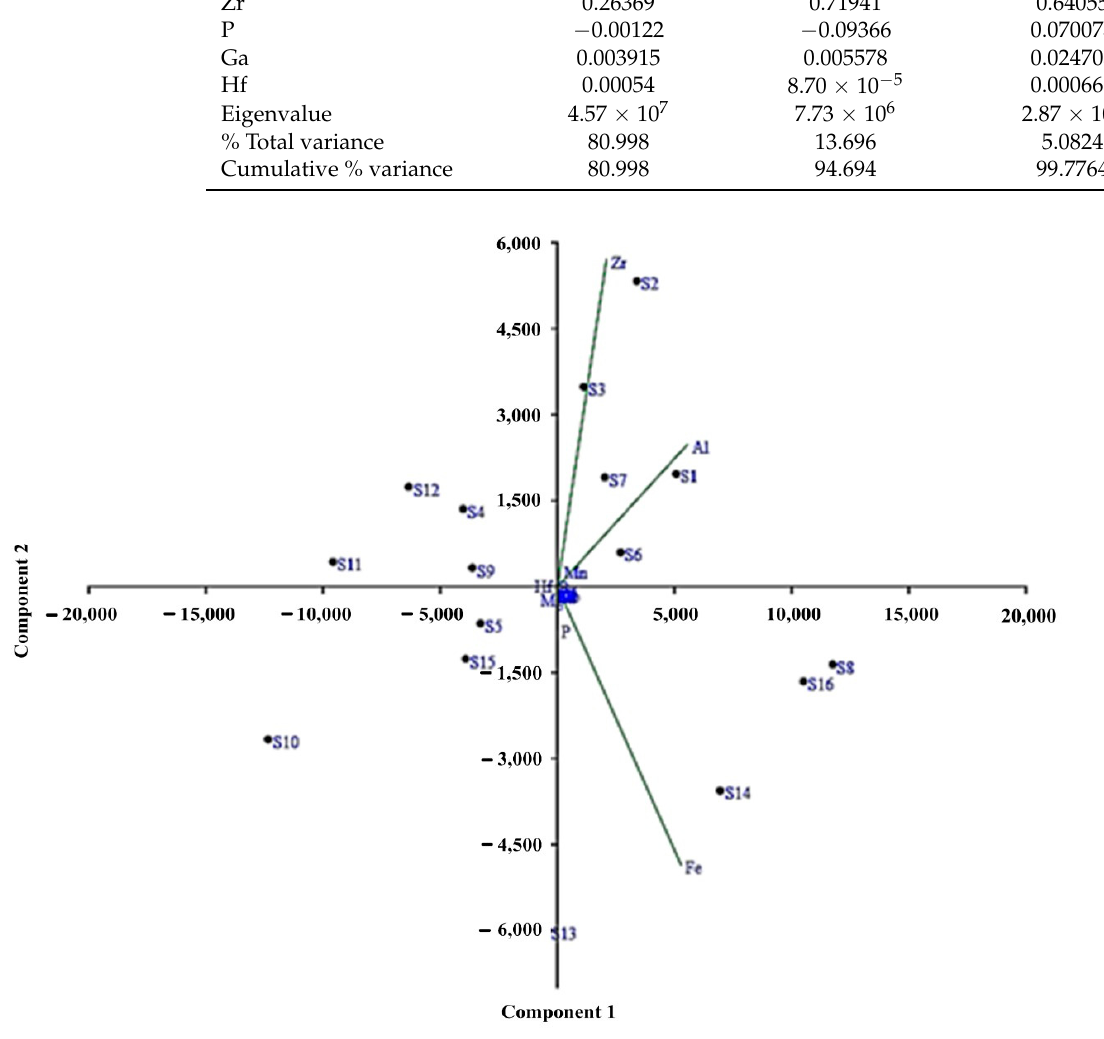
Figure 6. Principal component analysis for metals of Qaroun Lake sediment samples. 3.5. Performance efficiency of PLSR and MLR Models to Predict the Degree of Contamination (Dc), Pollution Load Index (PLI), and Potential Ecological Risk Index (RI) In Table 9, the calibration (Cal.) models presented the best performance efficiency to predict the PLI, RI and Dc, based on the 21 selected elements, with R 2cal = 0.961–0.991 and with ACC c = 0.981–0.999 for PLSR, and with R 2cal = 0.947–0.996 and with ACC c = 0.976– 0.998 for MLR. The validation (Val.) models also presented the best performance effi- ciency, with R 2val = 0.948–0.989 and with ACC v = 0.984–0.999 for PLSR, and with R 2val = 0.760–0.979 and with ACC v = 0.867–0.984 for MLR. The Val. Model of the PLSR method performed better efficiency to predict the PLI than the Val. Model of the MLR method (Table 9; Figures 7 and 8). In general, the Cal. and Val. models of the PLSR method showed